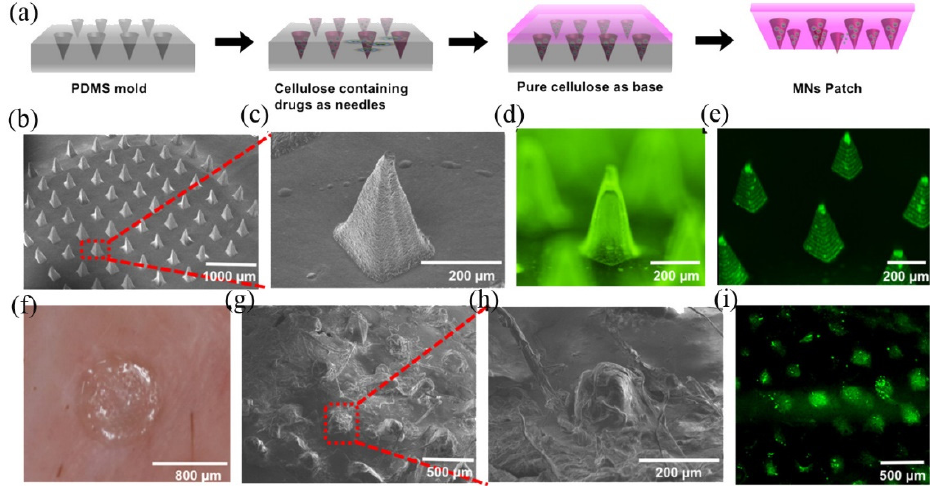
Figure 3. ( a ) Fabrication process of MNs. ( b ) SEM images of LCC-NP-coated MNs. ( c ) magnified SEM images of the MNs within the red box of ( b ). ( d ) fluorescence microscope image. ( e ) confocal image of NBD PE-labeled NP-coated MNs. ( f ) photograph of MN patch pressed into porcine skin. ( g ) SEM images of dissolved MN after inserting into the skin. ( h ) magnified SEM image of MNs in the red box of ( g ). ( i ) confocal image of porcine skin after treatment with NBD PE-labeled MNs. Reproduced with permission from [83] . Copyright American Chemical Society 2018.